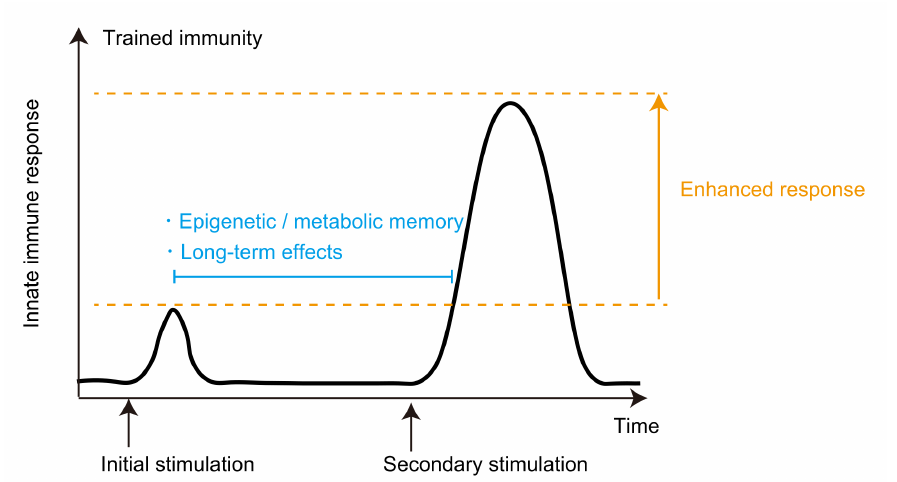
Figure 2. Trained immunity. Initial stimulations can trigger innate immune responses and estab- lish long-term memories via epigenetic and metabolic alterations. Secondary stimulations induce enhanced innate immune responses, leading to better resistance to diseases